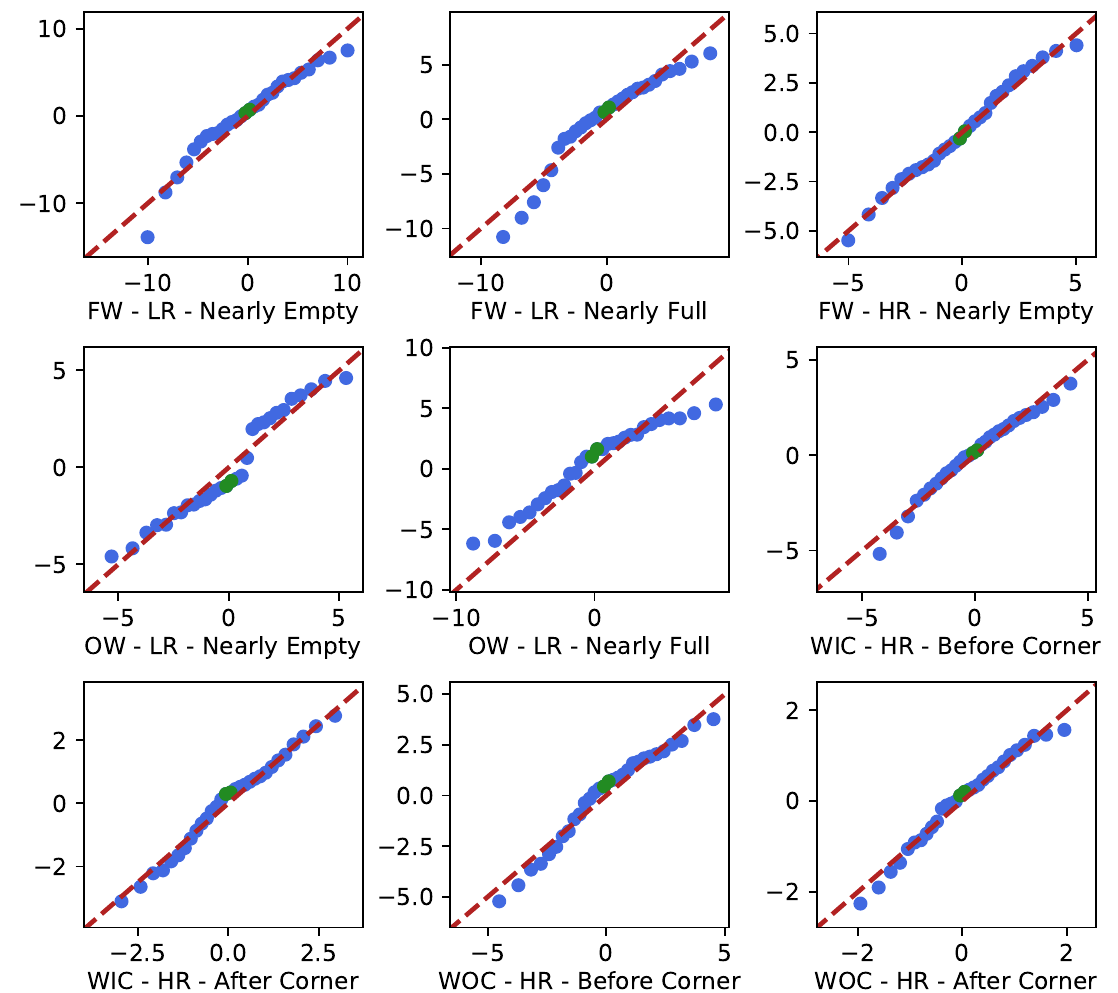
Figure 15. The Q-Q plots of the different scenarios. The blue points correspond to 30 equally large quantiles of the empirical distribution (y-coordinate, in dB) plotted against the same quantiles of the theoretical normal distribution (x-coordinate, in dB). The middle two quantiles are given in green, and the dashed red lines illustrates the first bisector (x =